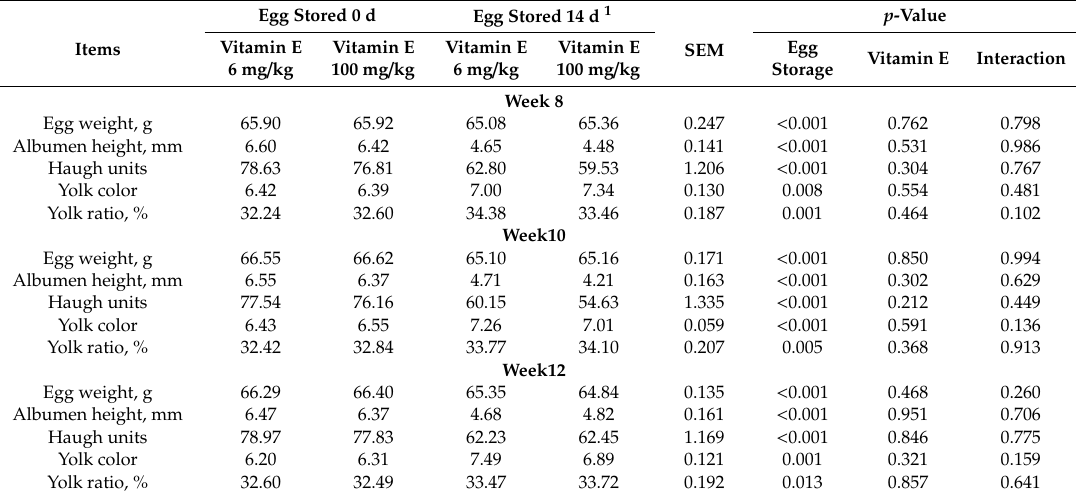
Table 2. Thee ff ects of broiler breeder dietary vitamin E and egg storage time on the egg characteristics.